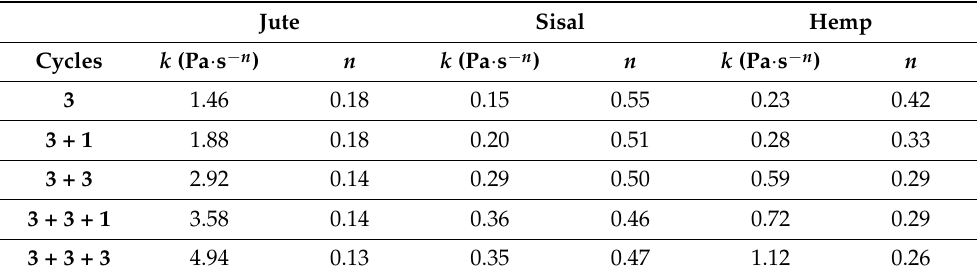
Table A6. Ostwald–de Waele fitting parameters for enzymatic MCNF (240